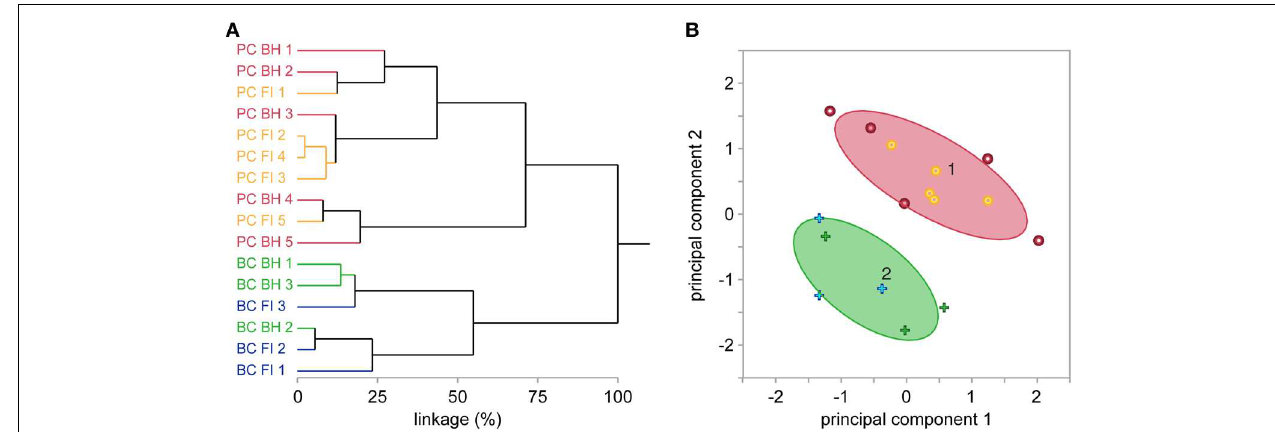
reconstruction, with coloring indicating cell and method type. Linkage distance is plotted on the x-axis, indicating the level of dissimilarity between clusters. (B) In agreement, expectation-maximization clustering also separated BCs from PCs. Crosses denote BCs, and dots PCs. As in (A) , coloring indicates reconstruction method (blue or yellow = FI; green or red = BH). Ovals denote the region where 90% of observations in each cluster are expected to